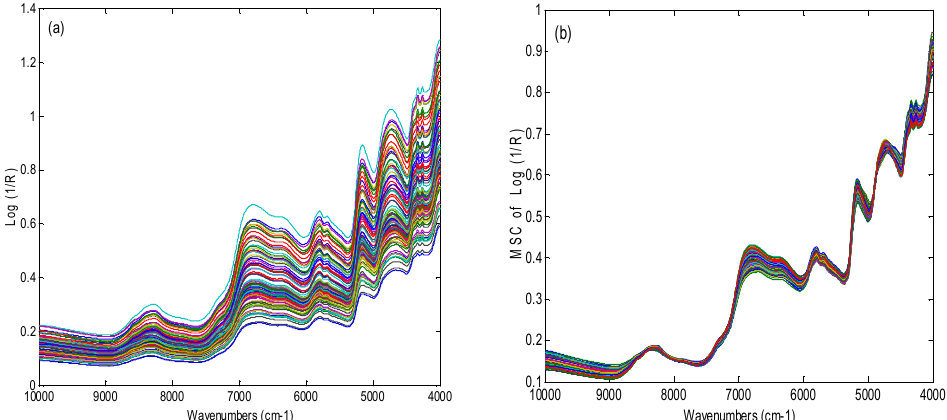
Figure 1. Spectra of Trichosanthis Fructus ( a ) raw data and ( b ) with multiplicative scatter correction (MSC) pretreatment.